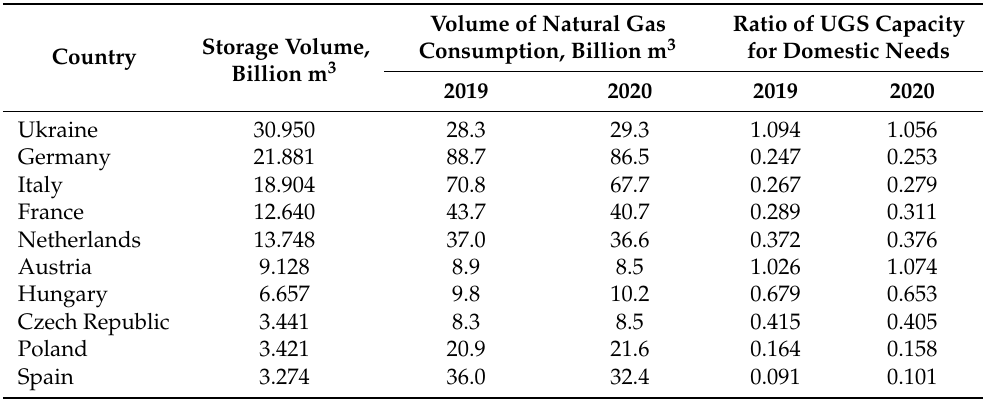
Table 9. Provision of underground storage facilities to the domestic needs of individual Euro- pean